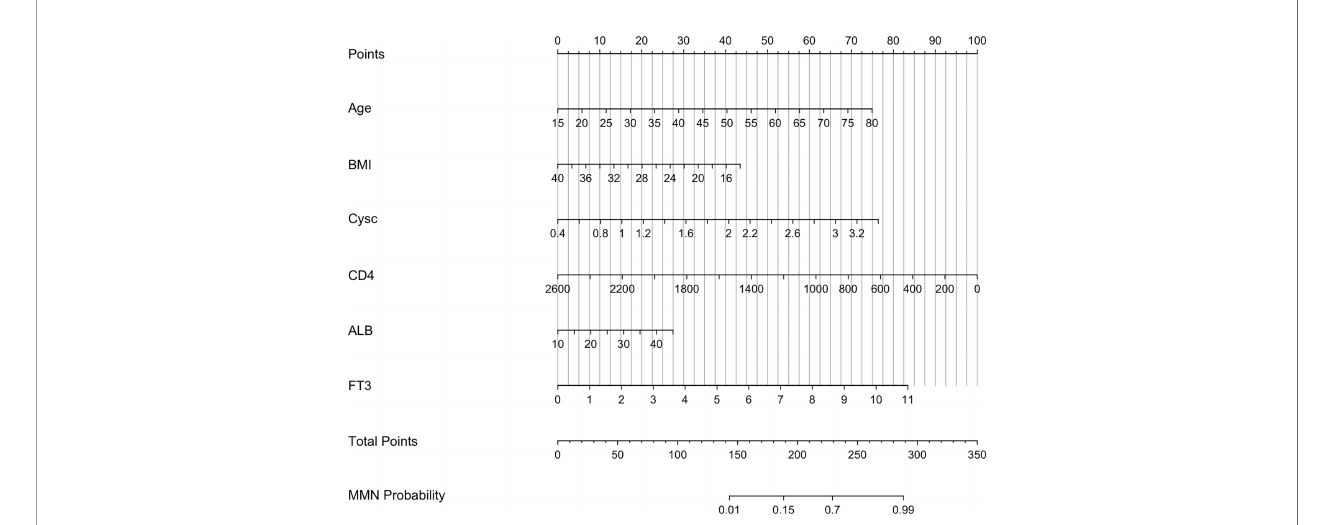
FIGURE 4 | Nomogram predicting MMN. Cysc, Cystatin C; CD4, CD4+ T cells count; ALB, albumin; FT3, free